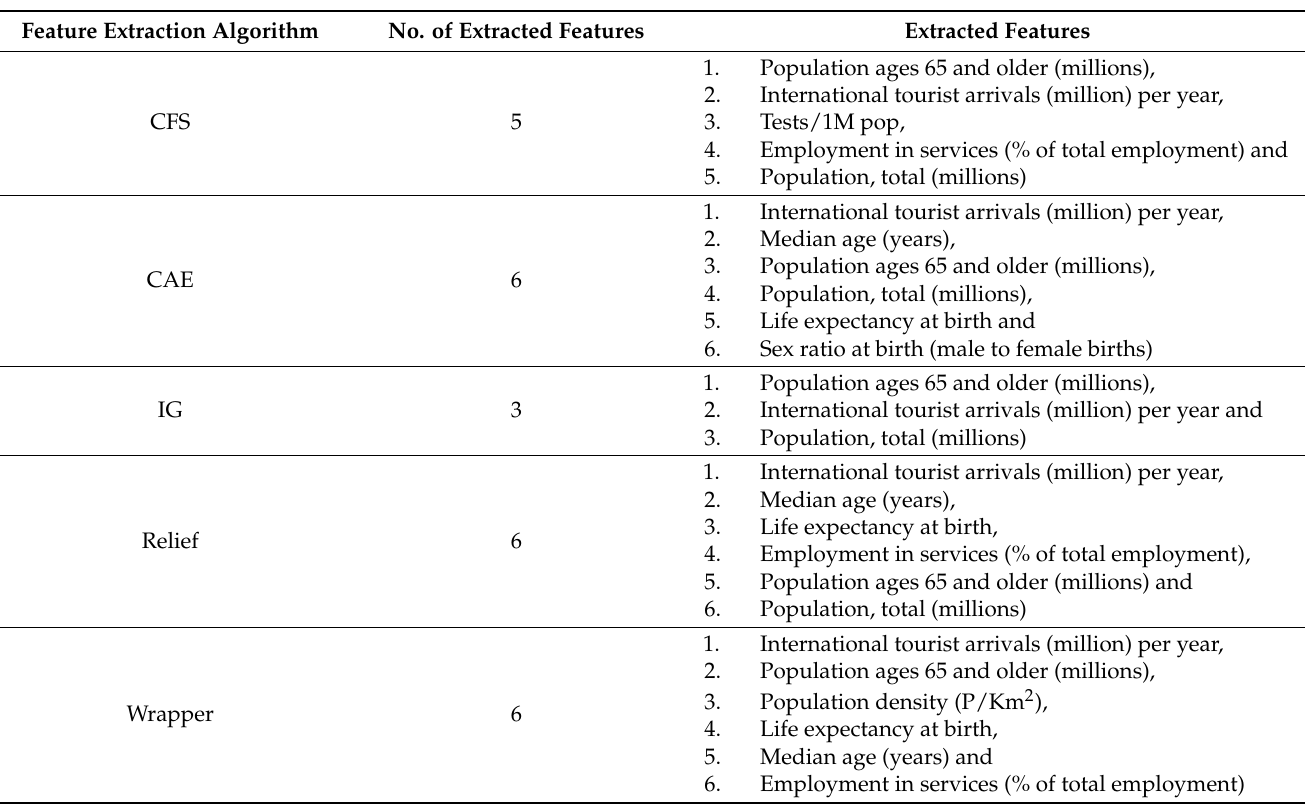
Table 12. The ranked features of the feature extraction algorithms to predict the total deaths.